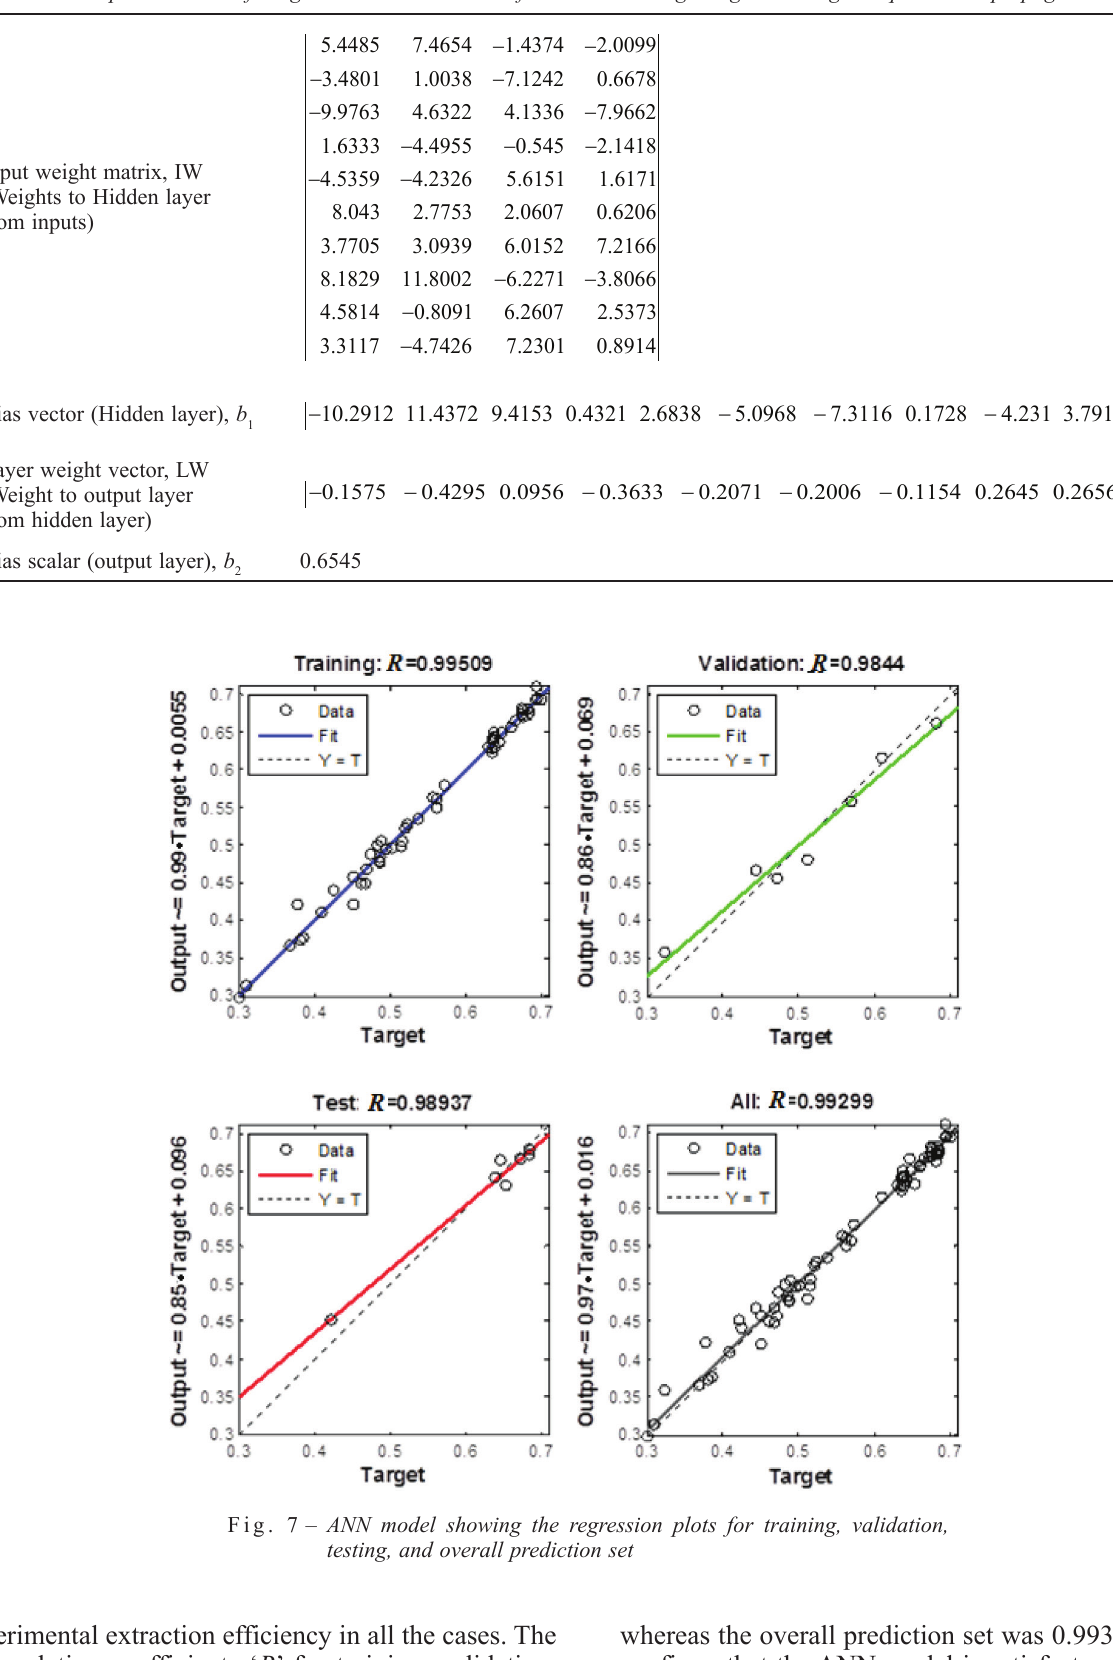
Table 5 – Optimal values of weights and biases obtained from ANN training using Levenberg-Marquardt backpropagation algorithm